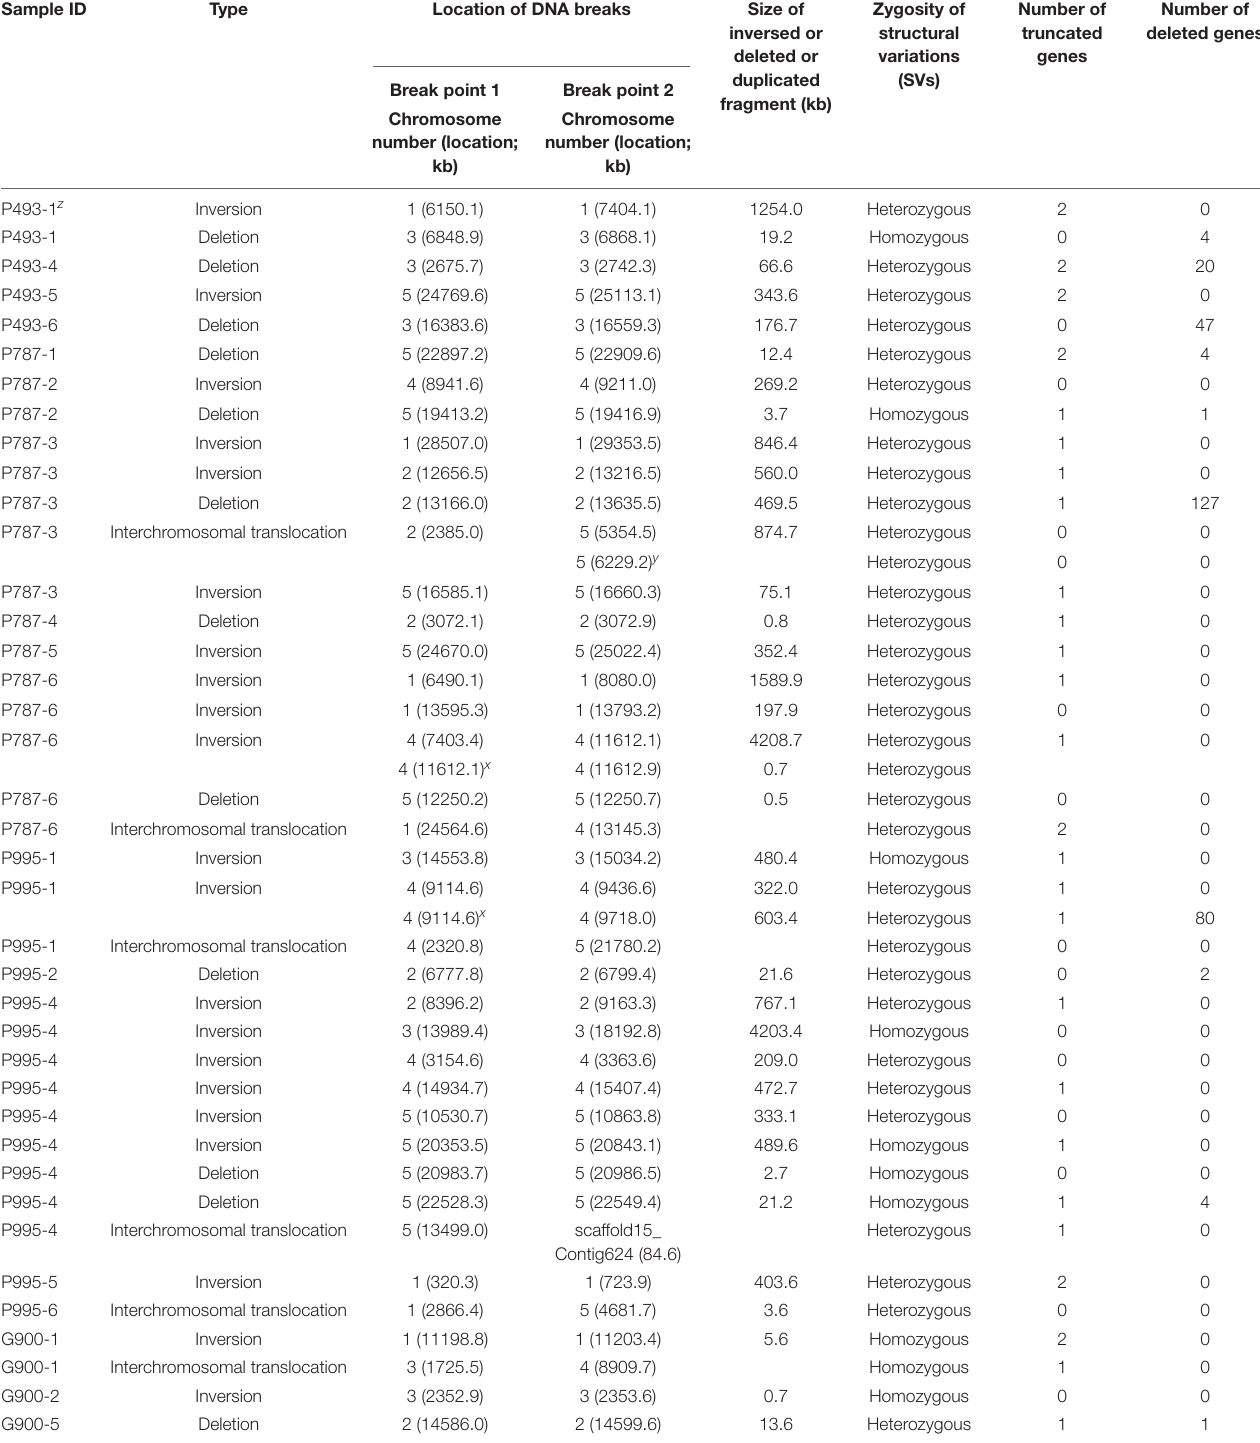
TABLE 2 | Structural variations in M 2 mutants of Arabidopsis irradiated with proton beams or gamma-rays. Sample